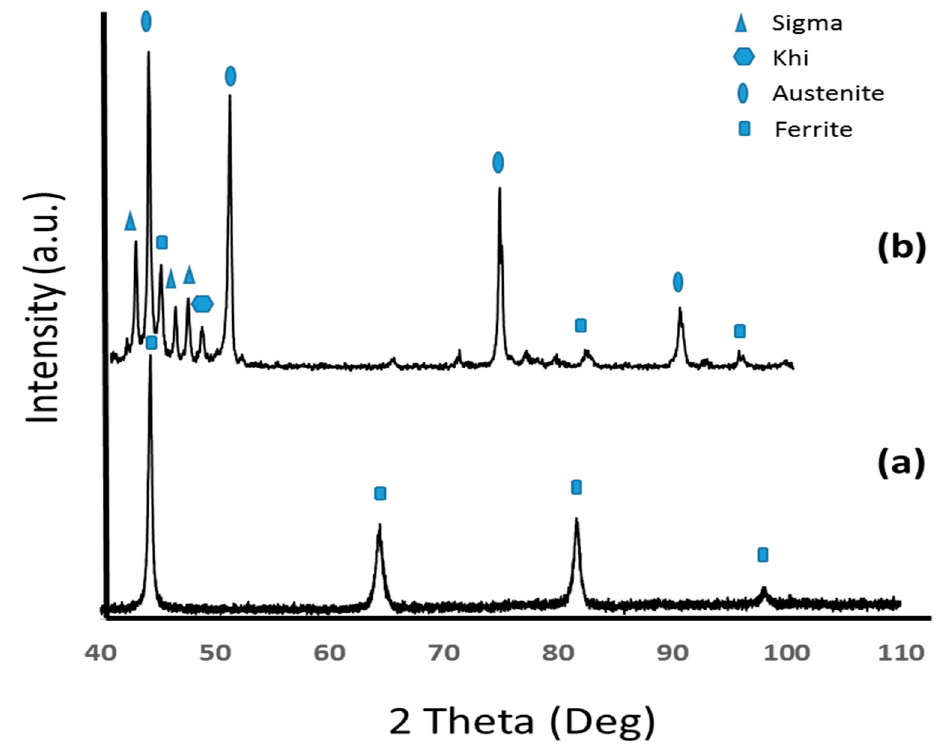
Figure 2. X-ray diffraction (XRD) phase analysis of SLM DSS 2507; ( a ) and as-built, ( b ) heat treated at 1200 °C.